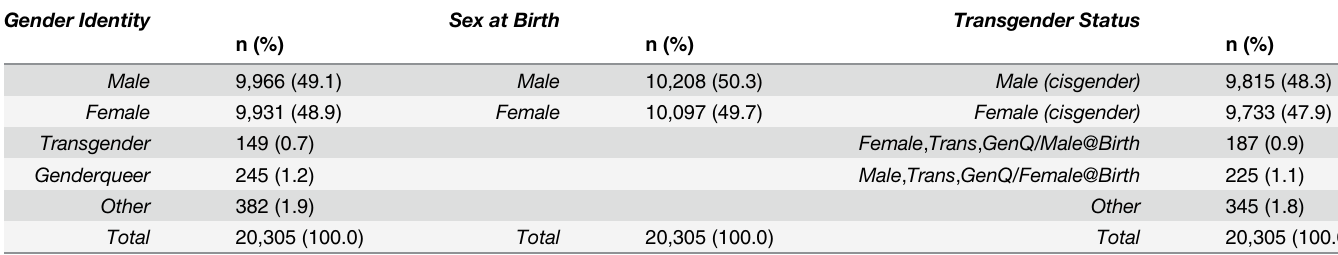
Table 3. Google Android Panel Reported Gender Identity and Sex at Birth, and Computed Transgender Status. Gender Identity